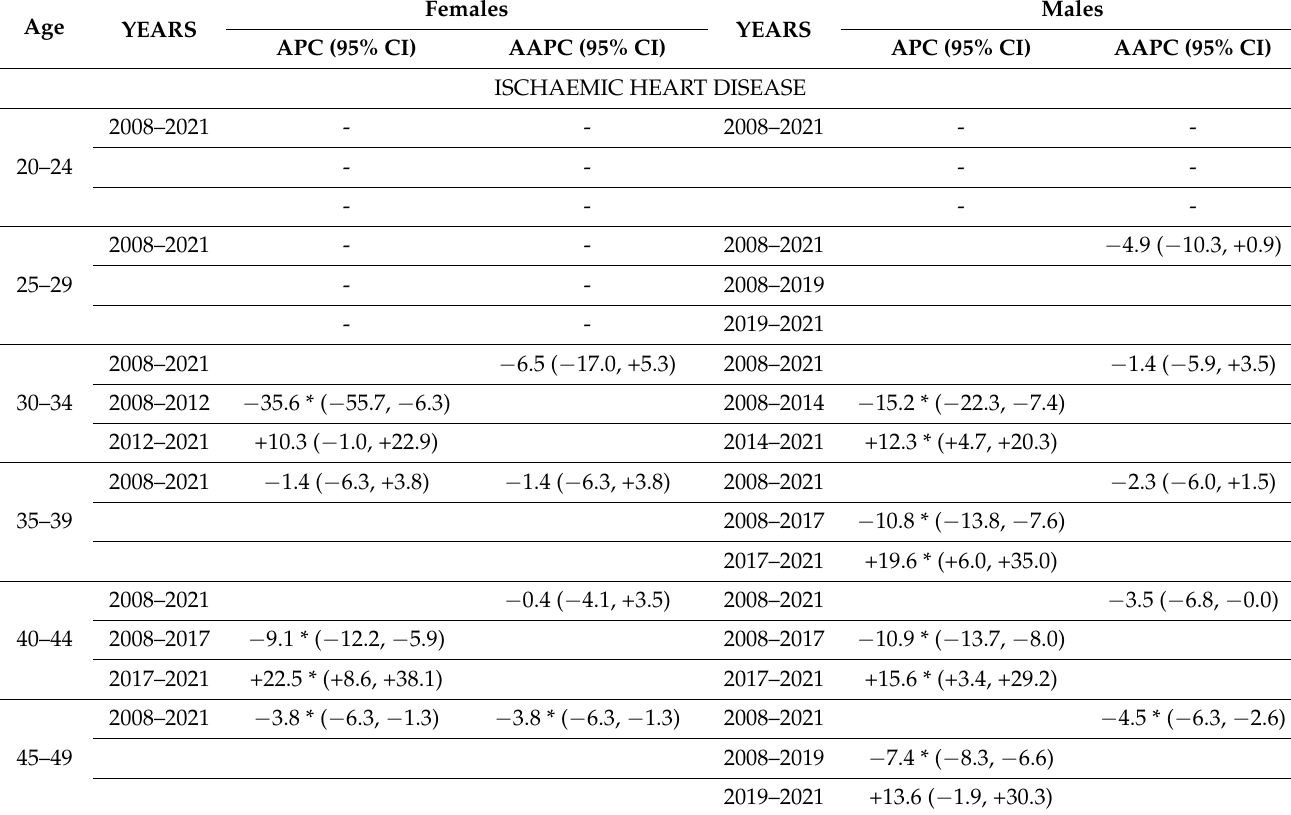
Table 4. Mortality trends due to groups of selected cardiovascular diseases in Poland by gender and